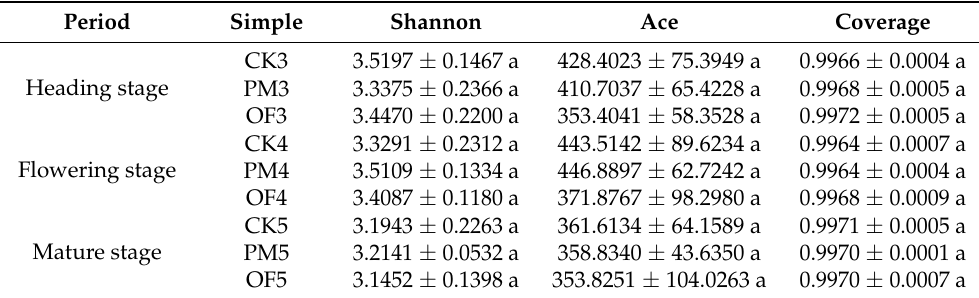
Table 3. Indexes of archaeal community diversity in paddy fields under different fertilization